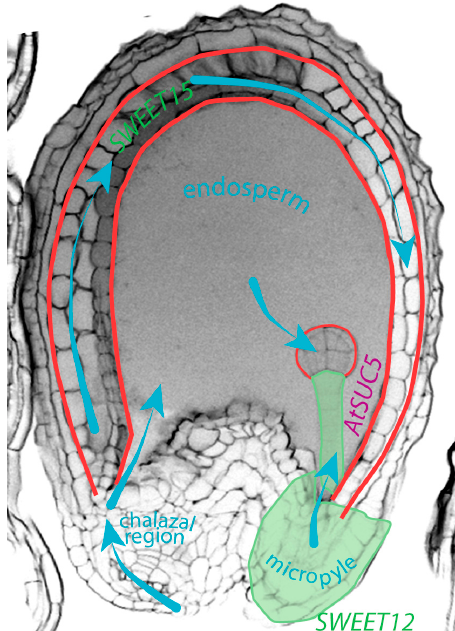
Figure 2. Symplastic barriers in the seed are illustrated (red): inner/outer integuments, inner integuments/endosperm, endosperm/embryo (cuticle). Blue arrows indicated the sucrose flow in the seed, deduced from feeding experiments in oilseed rape [56]. The expression pattern of SWEET12 (micropyle and suspensor) and SWEET15 (seed coat) is indicated in green [57]. The expression pattern of AtSUC5 in ESR is shown in purple [58].